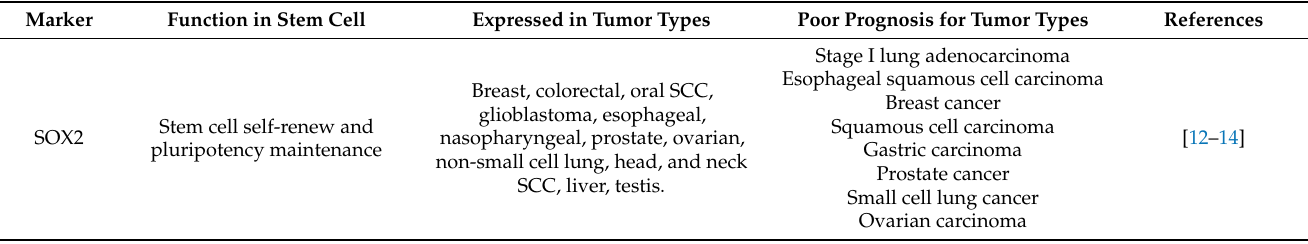
Table 1. Characteristics of stemness-related markers, including their function, localization of expres- sion, and types of neoplasms in which markers deteriorate